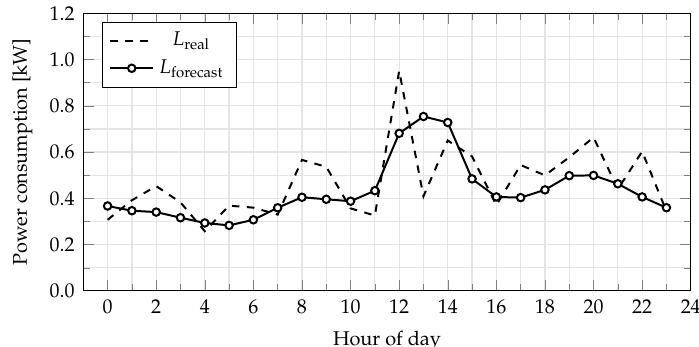
Figure 4. RESPOND energy demand forecasting service output for a dwelling in